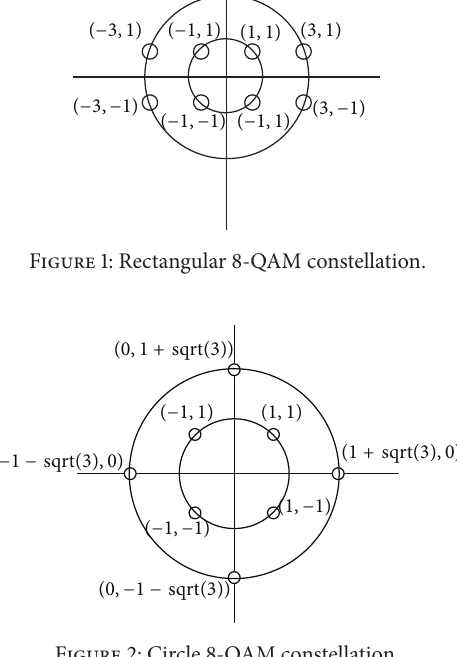
Figure 2: Circle 8-QAM